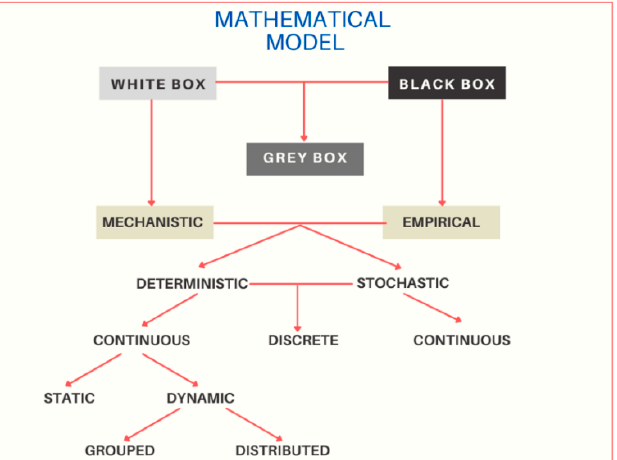
Figure 1. Classification of mathematical models. The diagram shows the three main classifications of the white box, black box and gray box models, and their sub-classifications of the white box or mechanistic, and black box or empirical models. Mechanistic and empirical models can be deterministic or stochastic; and in turn, they can be continuous or discrete.